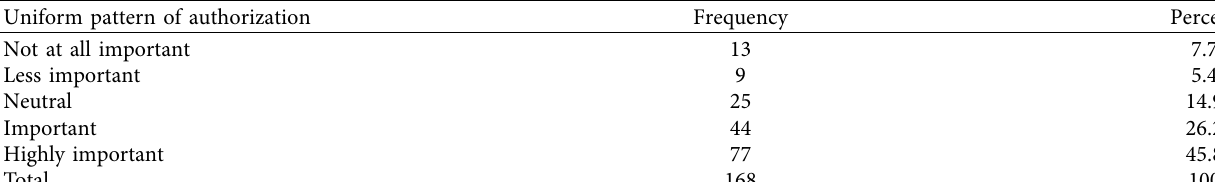
Table 1: Uniform pattern of authorization.